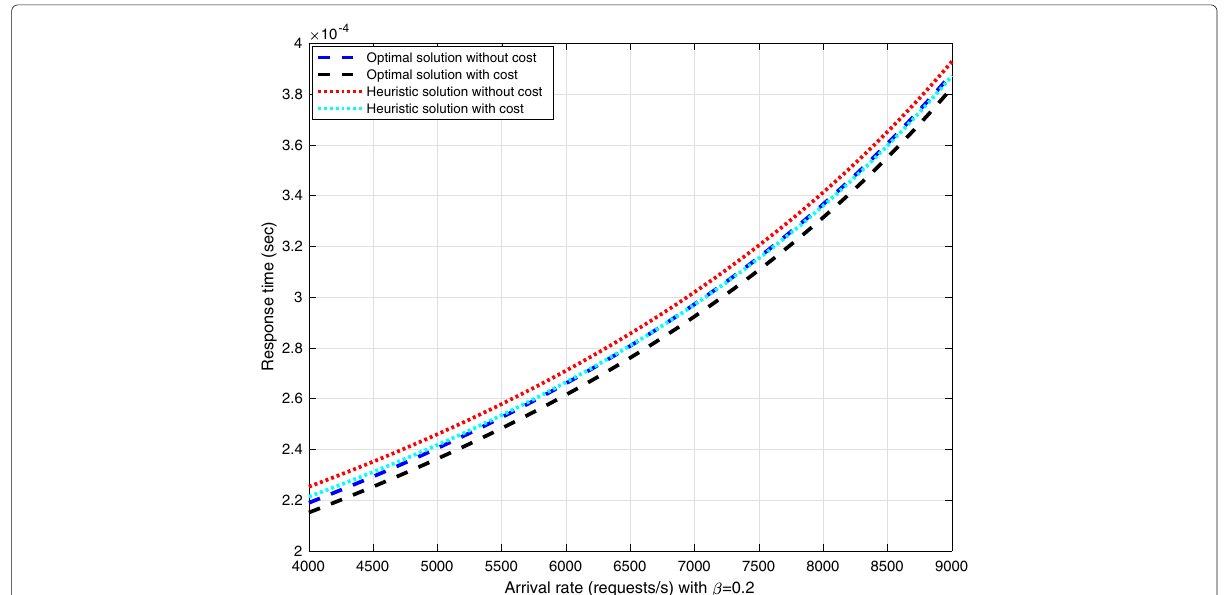
Fig. 13 Cost vs. time optimization. Optimal solution without cost, Optimal solution with cost, Heuristic solution without cost, Heuristic solution with